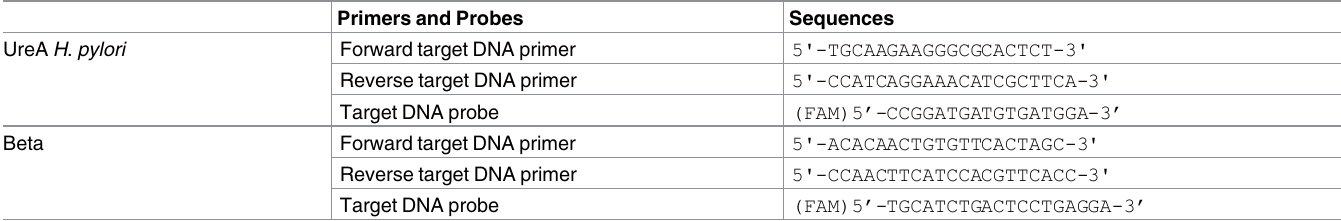
Table 2. Nucleotide sequences of primers and